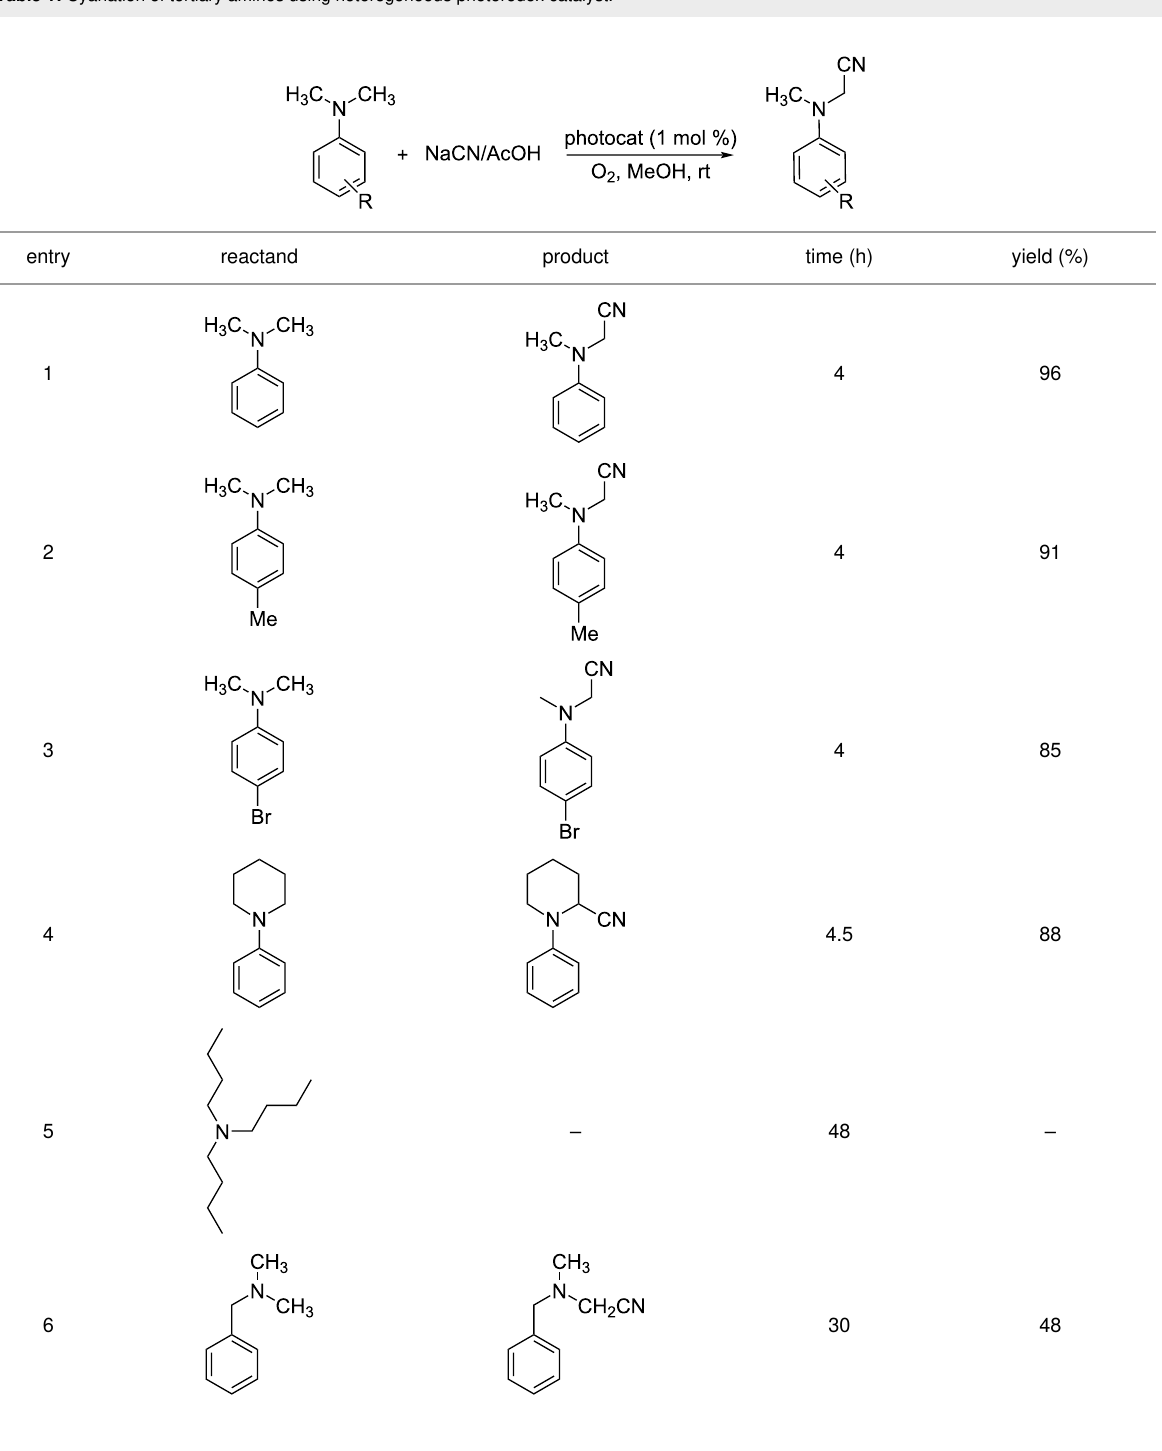
Table 1: Cyanation of tertiary amines using heterogeneous photoredox